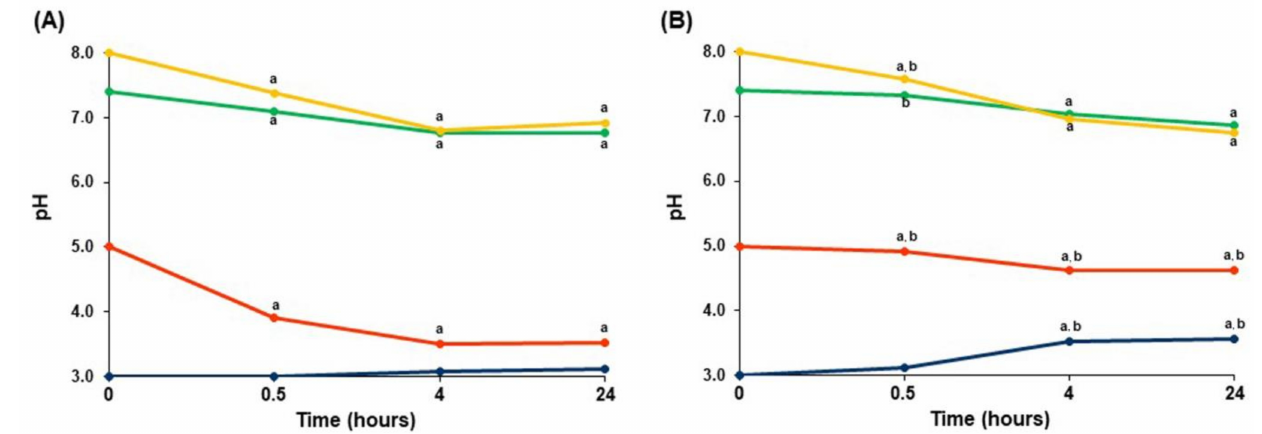
Figure 4. Variation in the pH values during incubation of AP4 ( A ) and HS4 ( B ) gel beads in PBS at different pH for 24 h. The data are presented as the mean ± S.D. ( n = 5). a p < 0.05 vs. corresponding initial pH; b p < 0.05 vs. the corresponding AP4 gel beads levels.